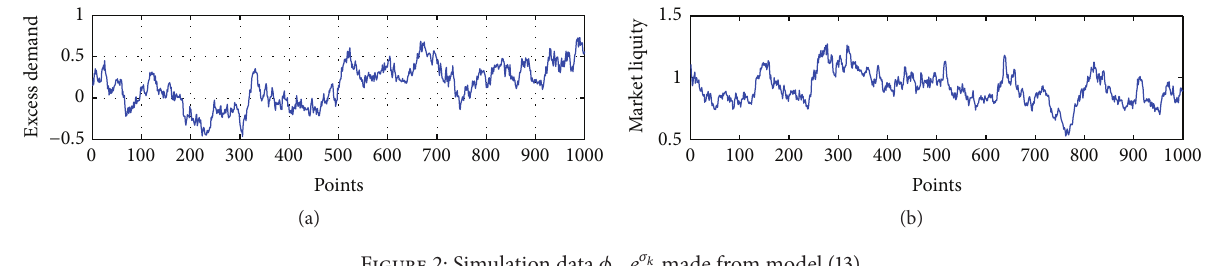
Figure 2: Simulation data 𝜙 𝑘 , 𝑒 𝜎 𝑘 made from model